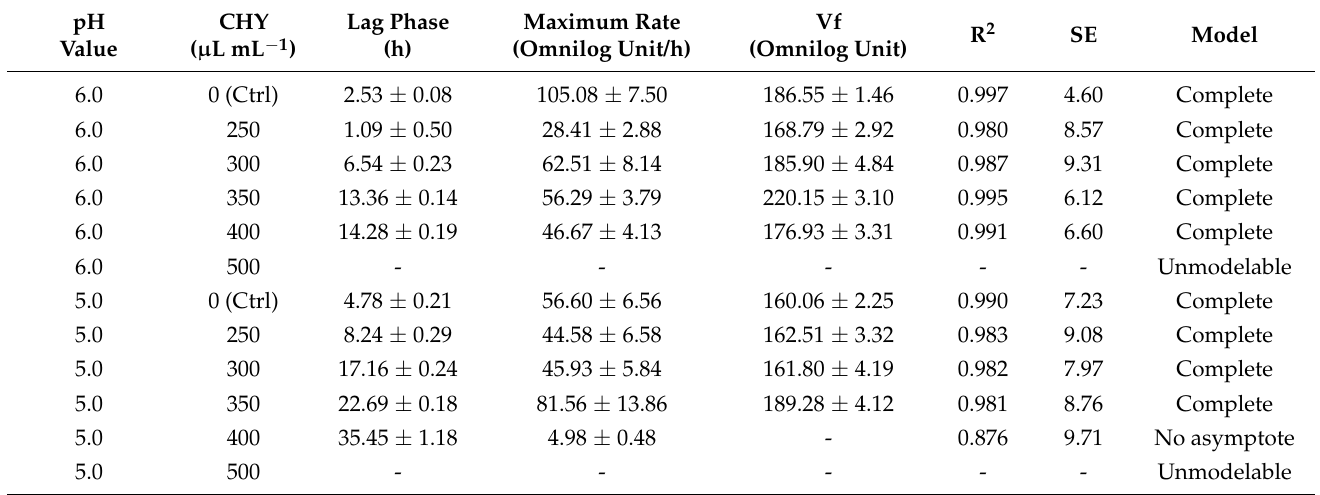
Table 3. Growth parameters of L. monocytogenes ATCC 7644 cells, previously exposed to increasing the Baranyi and Roberts model. The table displays: Lag phase (h), Maximum growth rate (Omnilog unit/h) the final (Vf) cell density value (Omnilog unit), the R-squared (R 2 ), the standard error (SE) and the assessment of the fitting model